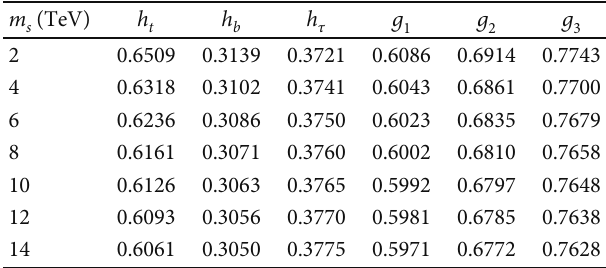
Table 4: Values of Yukawa and gauge couplings evaluated at t